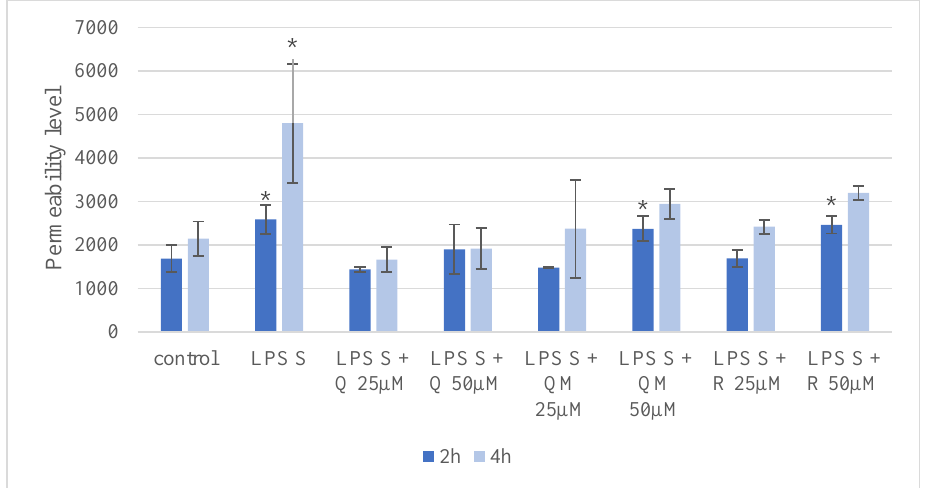
Figure 6. Penetration of FD4 from the apical to the basolateral compartment through IPEC-J2 cells after Salmonella Typhimurium LPS (LPS S) treatment (10 µg/mL, treatment time 1 h, detection after 2 h and 4 h) and with combinations of quercetin (Q), 3-o-methylquercetin (QM) and rhamnazin (R) using two concentrations (25 µM and 50 µM). Data are shown as means with standard deviations ( n = 3/group; * p < 0.05) and are statistically compared to those of the control group.